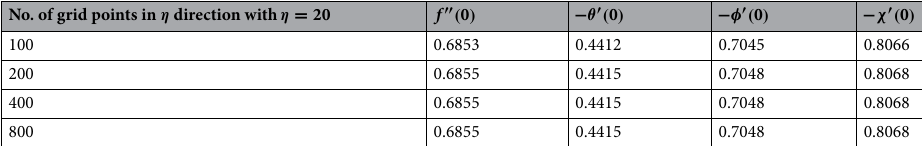
0.4, R 0.1, N r = = 0.1. =